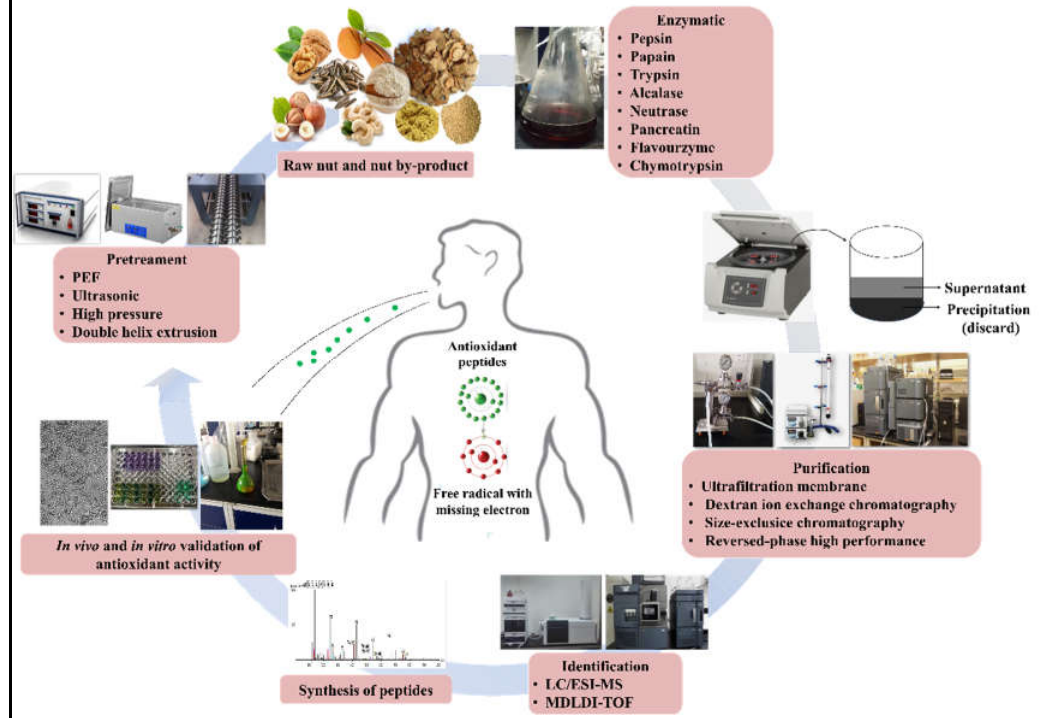
Figure 2. The schematic diagram for the production of antioxidant peptides from nut proteins. Ab- breviations: PEF, pulsed electric field; LC-MS/MS, liquid chromatography tandem mass spectrom- etry; MALDI-TOF, matrix-assisted laser desorption/ionization time of fight.